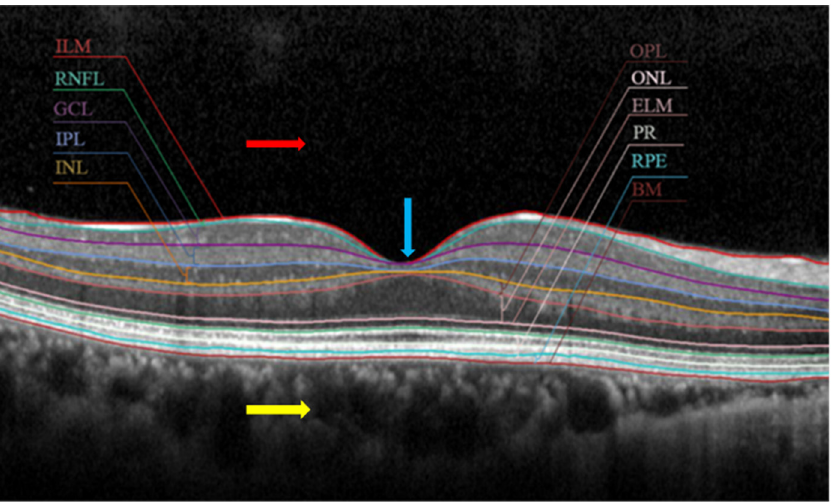
Figure 3. Different layers of macular OCT: vitreous (red), fovea (blue), and choroid (yellow). The outer retinal layers are the most hyperreflective band composed of more than one line, termed the photoreceptor inner–outer segment junction and the RPE layer. The line highlighted in red in Figure 4 is the junction between the inner and outer segments of photoreceptors, whereas the band highlighted in green is the RPE. These lines often seem merged but are separate lines. A further RPE layer consists of two different layers believed to be RPE’s inner and outer membranes. Above the RPE and the photoreceptor inner ‐ outer segment junction, the photoreceptor and the outer plexiform layer are present. The outer plexiform layer is spread with the entire length of RPE and the edge of the fovea. Another important layer of the retina is the retinal nerve fibre layer (RNFL), whose thick ‐ ness determines the glaucoma disease’s presence. Sometimes RNFL is misinterpreted in the patient having posterior vitreous detachment (PVD). Figure 4. Outer retinal layer (red—photoreceptor, green—RPE, red circle—junction of photorecep ‐ tor). PV is the outermost layer of the retina that prevents the retina from exposure to vit ‐ reous liquid. The green line in Figure 5 shows the RNFL, and the red line shows the pos ‐ terior vitreous layer. The nasal side of the image can be identified from the thickness of the RNFL, where a thicker RNFL is seen towards the nasal area, and a thinner RNFL is seen towards the temporal region.